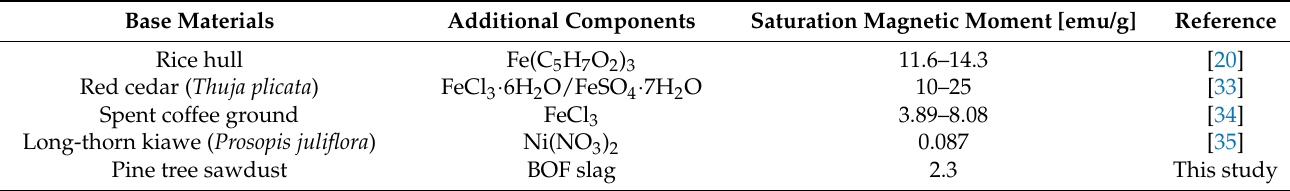
Figure 4. Magnetic hysteresis loop curve of MSSB (10,000 Oe = 1 Tesla). Table 3. The saturation magnetic moment of magnetic biochar.